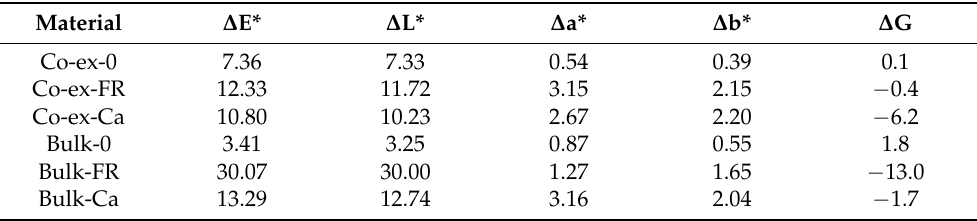
Table 14. Lightness ( ∆ L*), color ( ∆ a*, ∆ b*, and ∆ E*), and gloss ( ∆ G) changes of wheat straw-based, fire-retarded, co-extruded profiles after artificial weathering for 28 days according to DIN EN ISO 4892-2 (cycle 2). For composition of the formulations, see Material and Methods. Formulations did not contain any UV absorber, HALS, or acid scavenger.